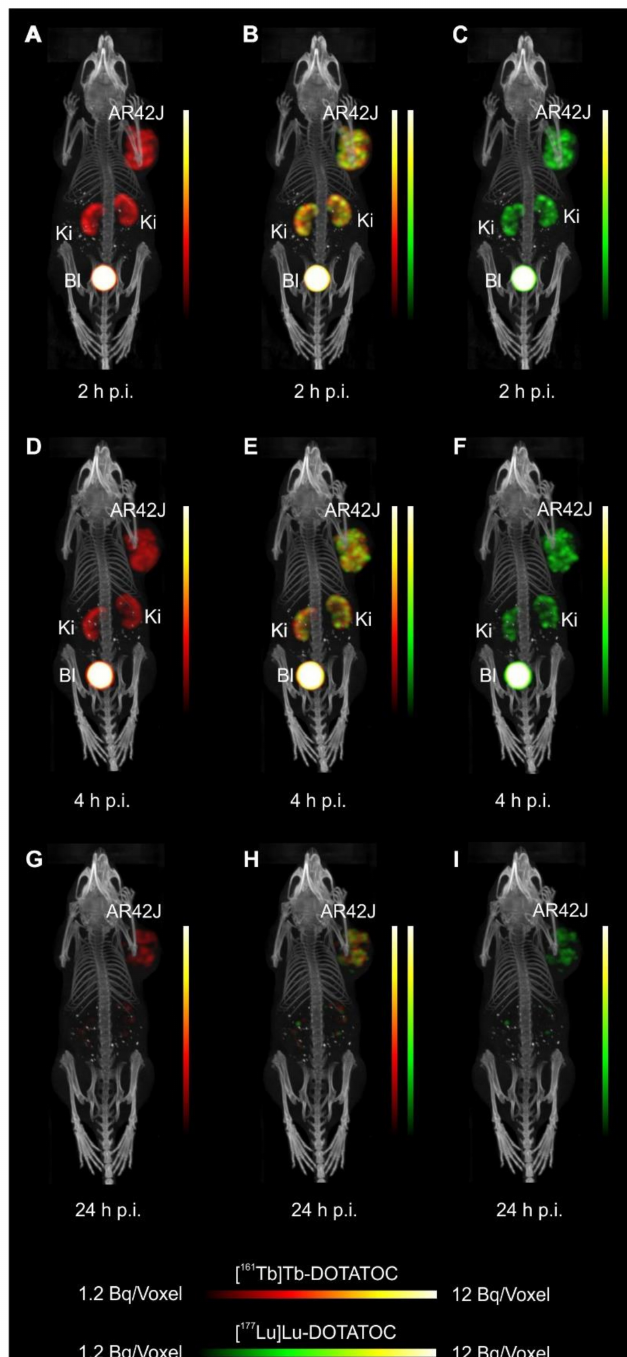
Figure 3. Dual-isotope SPECT/CT images of AR42J tumor-bearing mice shown as maximum intensity projections (MIPs) 2 h, 4 h and 24 h after injection of [ 161 Tb]Tb-DOTATOC (15 MBq, 0.5 nmol/mouse) and [ 177 Lu]Lu-DOTATOC (15 MBq, 0.5 nmol/mouse). ( A – C ) Scans acquired 2 h p.i. of the radiopep- tides; ( D – F ) Scans acquired 4 h p.i. of the radiopeptides and ( G – I ) Scans acquired 24 h p.i. of the radiopeptides. ( A , D , G ) Reconstructions based on the X-rays and γ -lines of terbium-161; ( B , E , H ) Re- constructions based on the X-rays and γ -lines of terbium-161 and the γ -lines of lutetium-177; ( C , F , I ) Reconstructions based on the γ -lines of lutetium-177. AR42J = SSTR-positive tumor xenograft; Ki = kidney; Bl = urinary